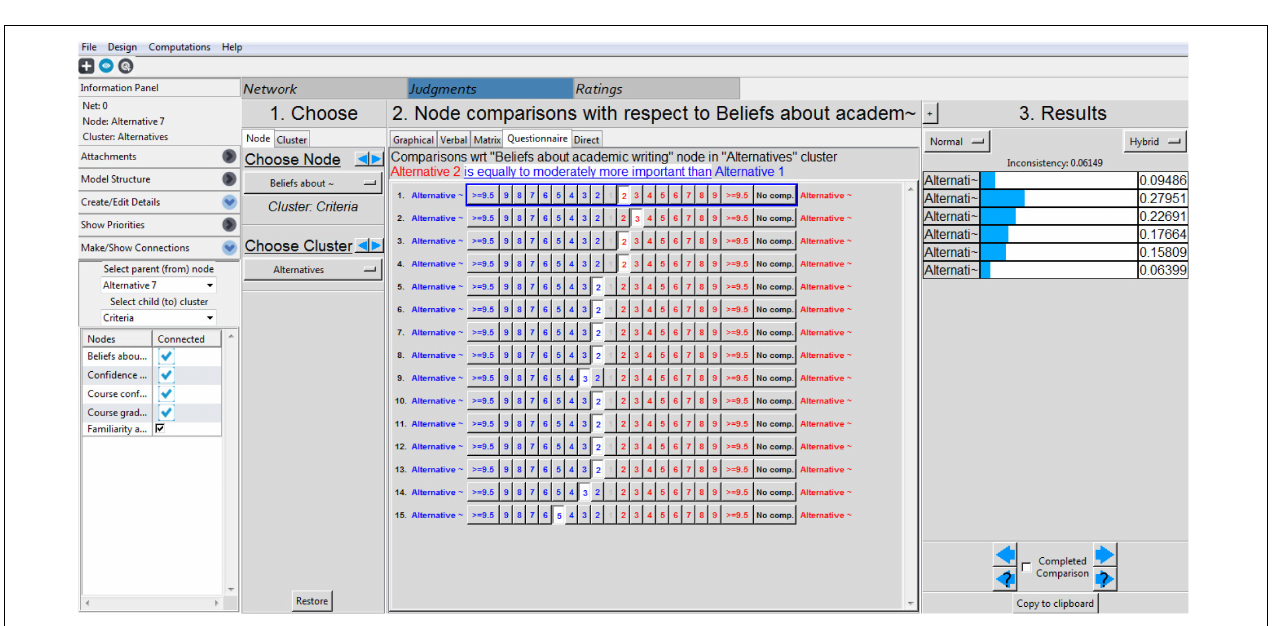
FIGURE 1 | Process of the proposed research for prioritization, criteria, and alternatives. Permission to reproduce images of Super Decisions has been given by Creative Decisions Foundation.